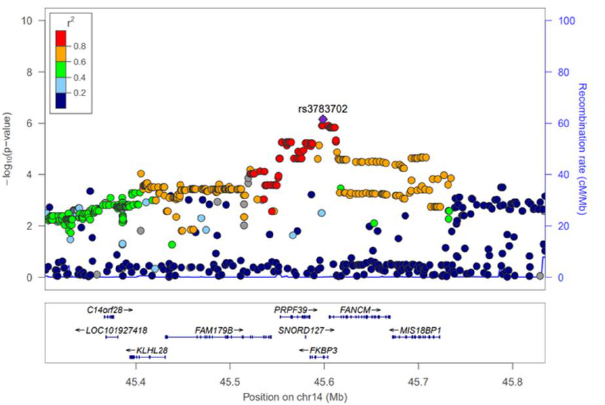
Figure 1. Regional association plot for the 14q21.2. The statistical significance ( − log 10 p -value) of the SNPs for the association results with HKD at the combination phase is plotted. The colors show the linkage disequilibrium ( r 2 ) between the SNP with the lowest p -value and the remaining SNPs. The genetic recombination rate is shown on the right vertical axis. The plots were generated by the LocusZoom website (http://csg.sph.umich.edu/locuszoom/, accessed on 10 May 2021).